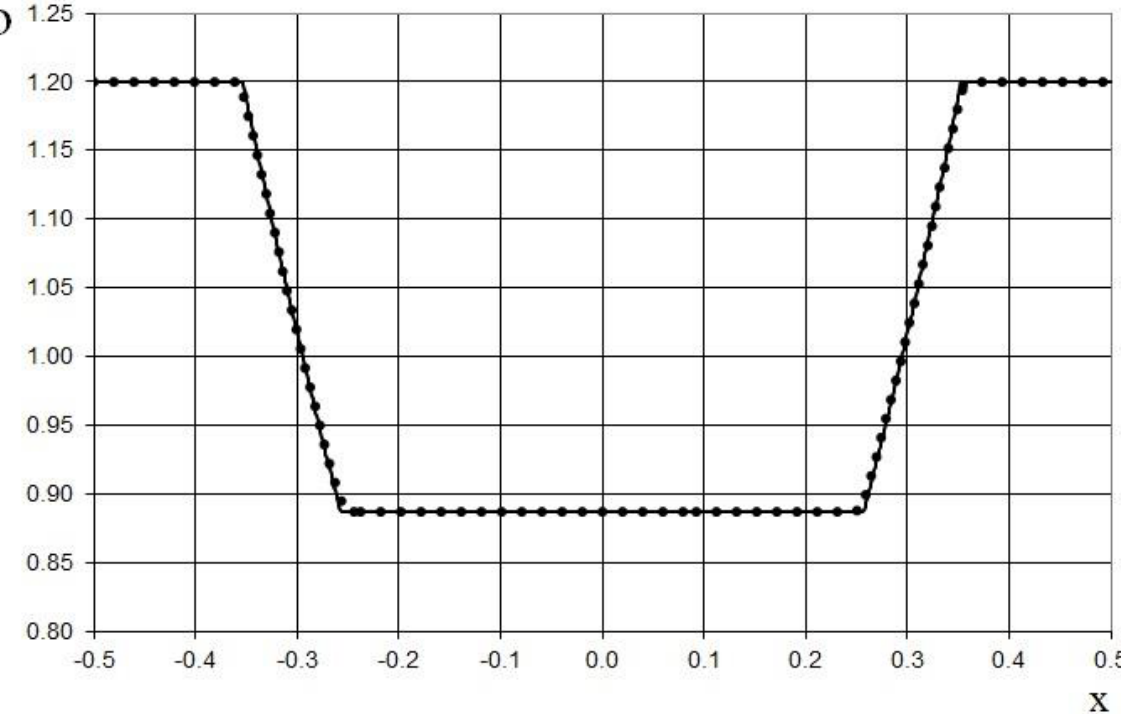
Figure 19. Pressure plot for the double expansion wave problem (47) for the one-dimensional scalar hyperbolic conservation law, using the coarse grid (100 grid points): the exact solution (line), and the present method (cross).